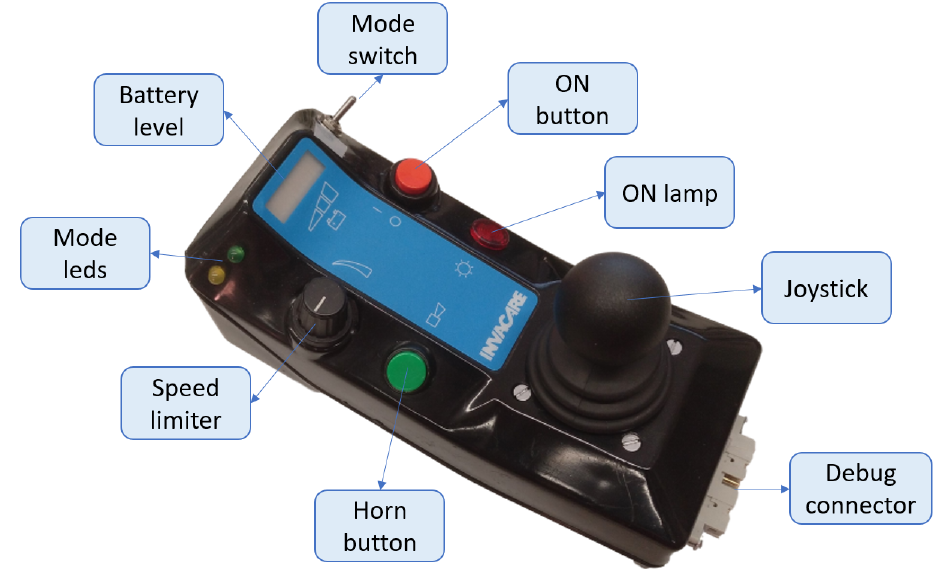
Figure 8. IW joystick node: components, status displays, and